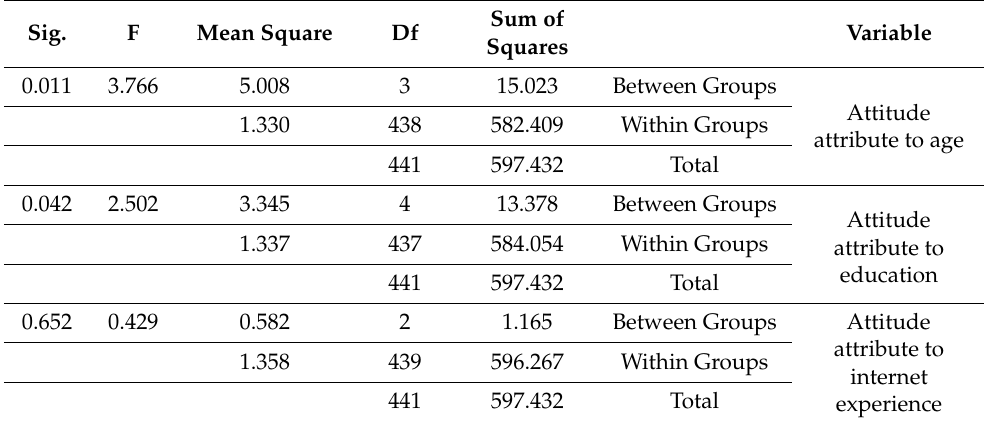
Table 8. ANOVA Analysis of respondent Attitude attributed to Age, Educational Level, and Inter- net